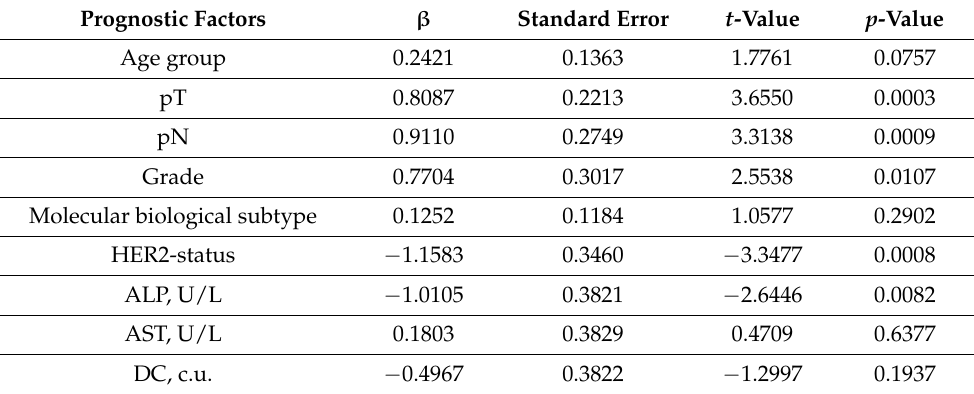
Table 4. Results of multivariate survival analysis using the Cox regression model ( χ 2 = 69.67, p <